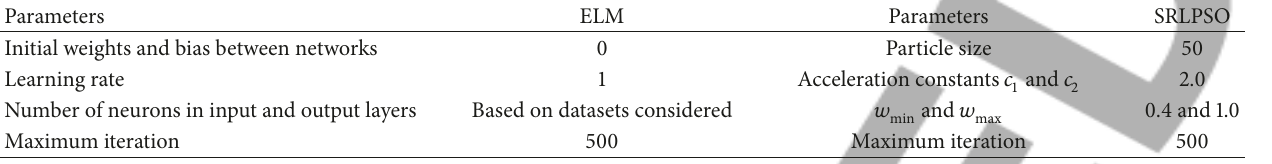
Table 2: Parameters for the proposed